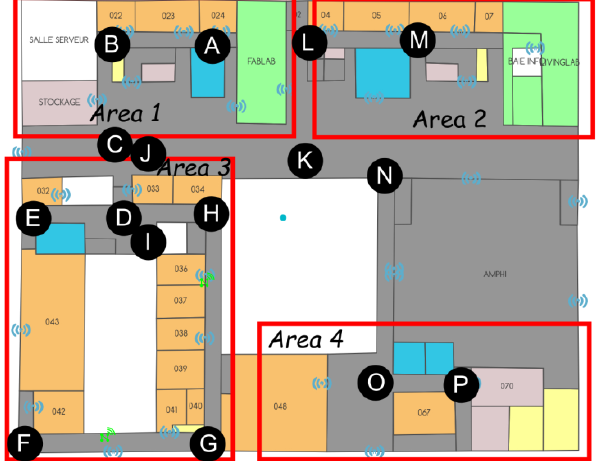
Figure 9. Definition of a “path”, in this case, from “A” to “P”.